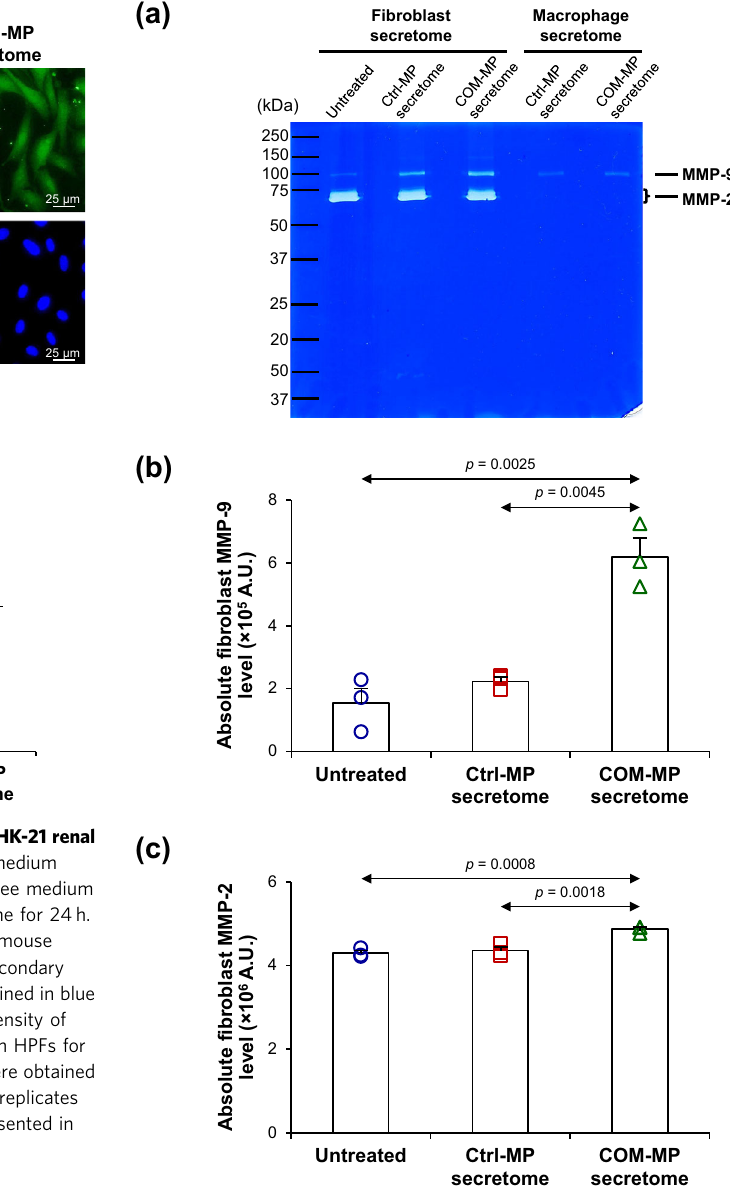
Fig. 9 Effects of COM-MP secretome on MMPs activities. BHK-21 cells were incubated in fresh serum-free medium without any treatment (untreated control) or in fresh serum-free medium mixed 1:1 (v/v) with Ctrl-MP secretome or COM-MP secretome for 24 h. Thereafter, the clari fi ed culture supernatant was subjected to gelatin zymogram assay. a MMP-9 and MMP-2 appeared as transparent bands at approximately 90 kDa and 65-70 kDa, respectively. b , c Absolute fi broblast levels of MMP-9 and MMP – 2, respectively, were calculated using Formula 3. The data were obtained from three independent experiments using different biological replicates and the bars indicate mean ± SEM (all the source data are presented in Supplementary Data 6 and Supplementary Data 7, respectively). A.U. = arbitrary